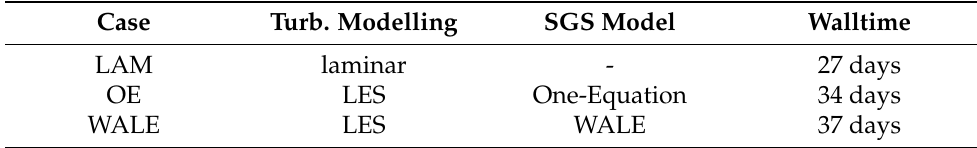
Table 3. Overview of the CFD simulations.